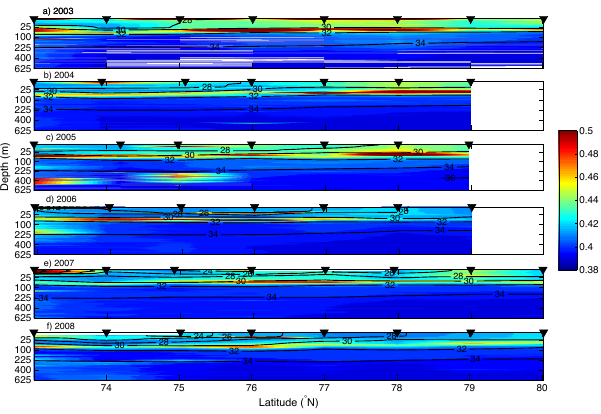
Fig. 10. As in Fig. 8 but for the eastern Northwind Region slope region. This region was sampled along a southern line (latitudes 75–76 ◦ N) and along a northern line (latitudes 78–79 ◦ N). Here, the northern line is shown on the right for (a) 2005, (c) 2006, (e) 2007, and (g) 2008 and the southern line is shown on the right for b) 2006, (d) 2007, and (f) 2008. Only one station was sampled along each line in 2003, 2004 and the southern region in 2005. The attenuation range is about half what it is in Fig. 8.